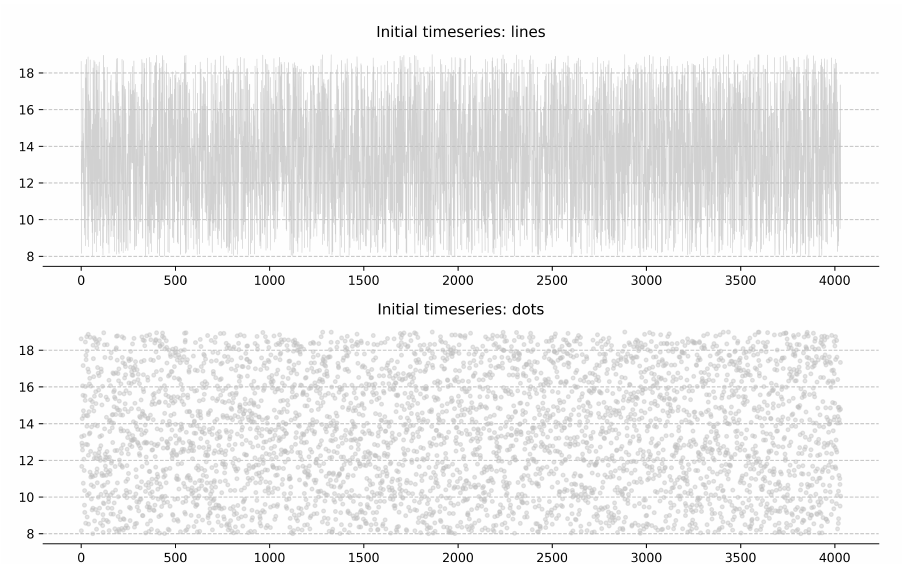
Figure 16. Numenta Anomaly Benchmark time series (no anomalies). Highly noisy data (art_noisy.csv).